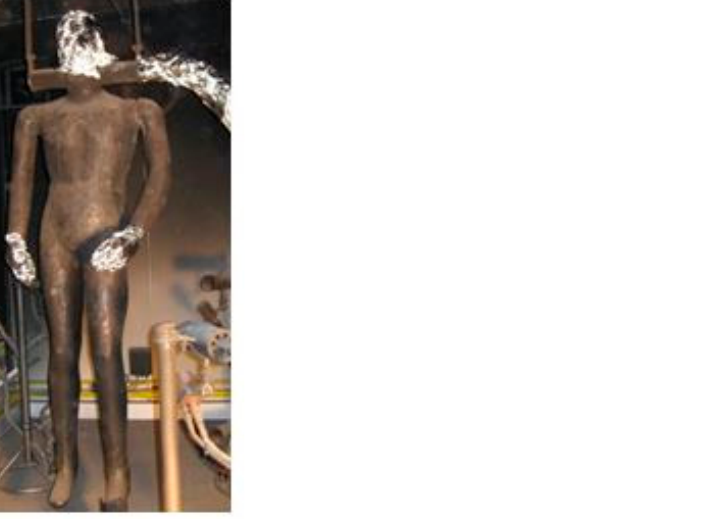
Figure 3. Fire manikin Žiga (Institut Jožef Štefan, Ljubljana, Slovenia).